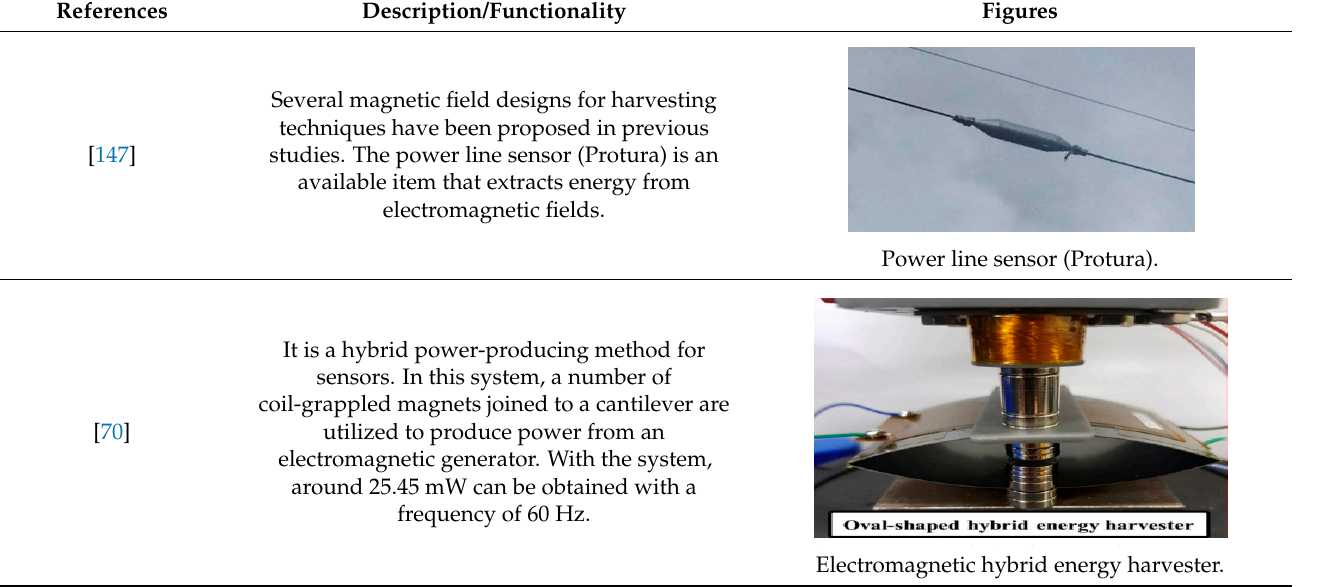
Table 5. Electromagnetic energy-harvesting devices’ specifications and figures.